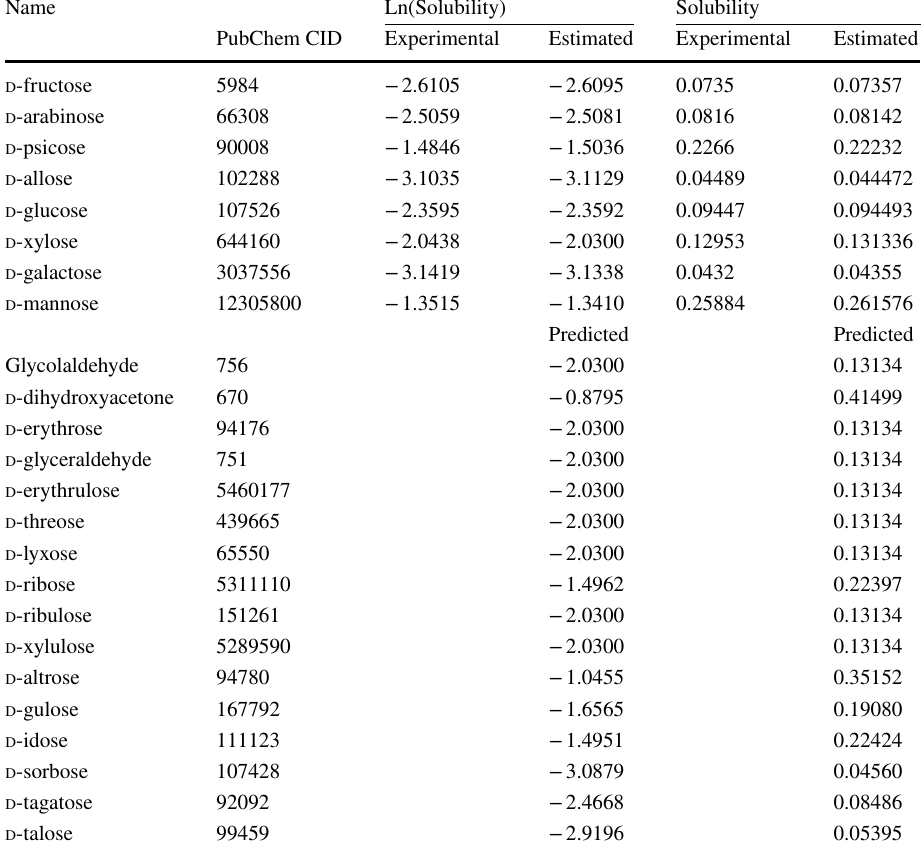
estimated and predicted solubilities of